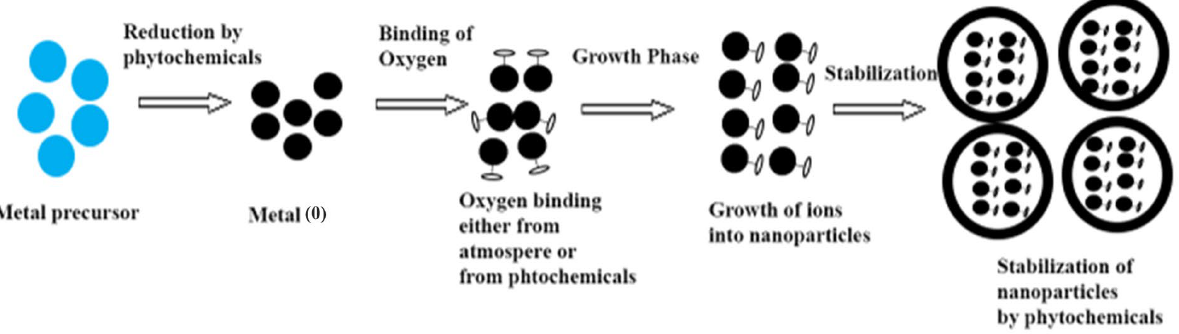
Figure 6. Mechanism of biogenic synthesis of CuO NPs.